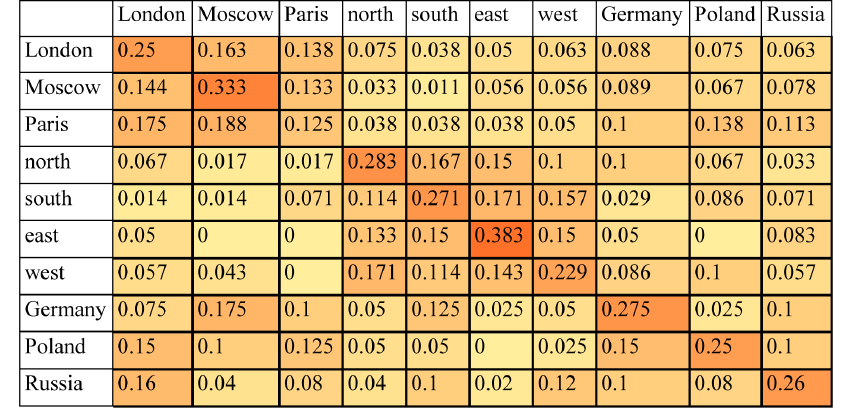
Figure 9. Conditional probability density estimates (shown as a heat map) from a new single-trial classification of the brain data (S18) for { London,Moscow,Paris,north,south,east,west,Germany,Poland,Russia }.